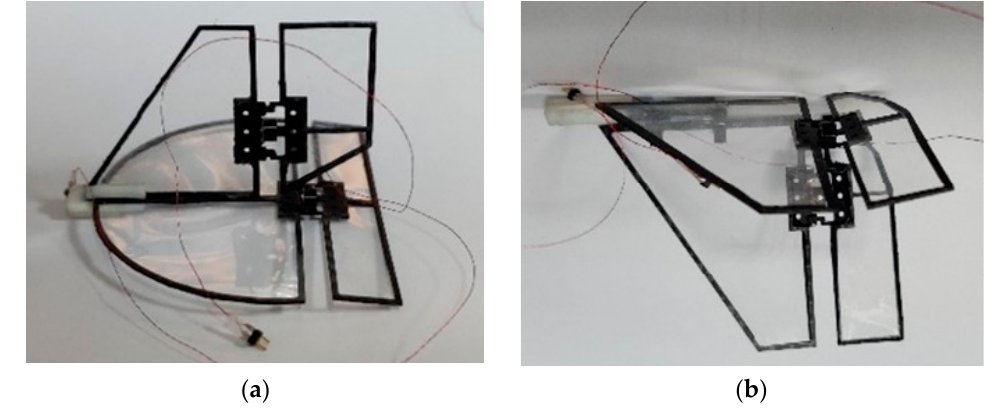
Figure 1. Reference experimental setup.